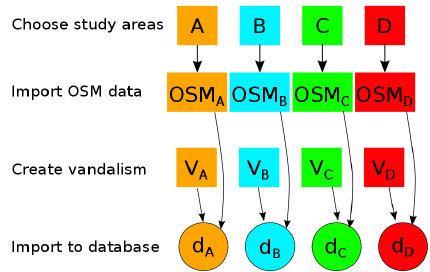
Figure 3. Building a vandalism corpus in OSM on four different